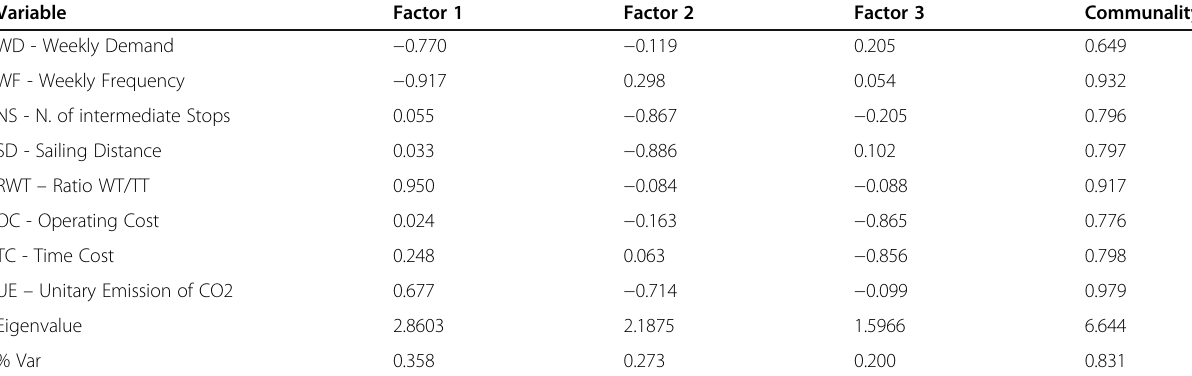
Table 12 Rotated factor loadings and communalities using Varimax rotation – Optimized network